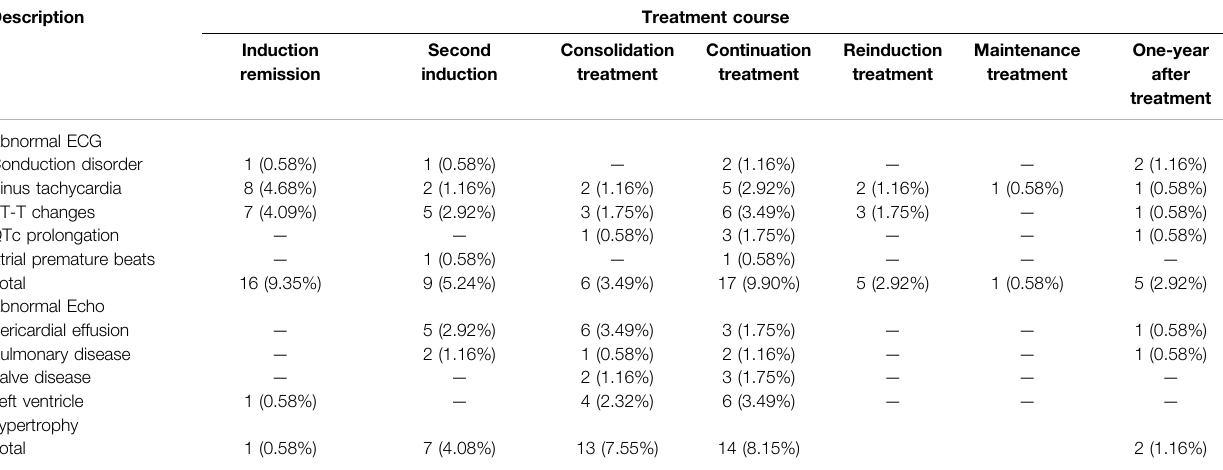
TABLE 4 | Subclinical cardiac disorders overt the course of 1-year on-protocol therapy.